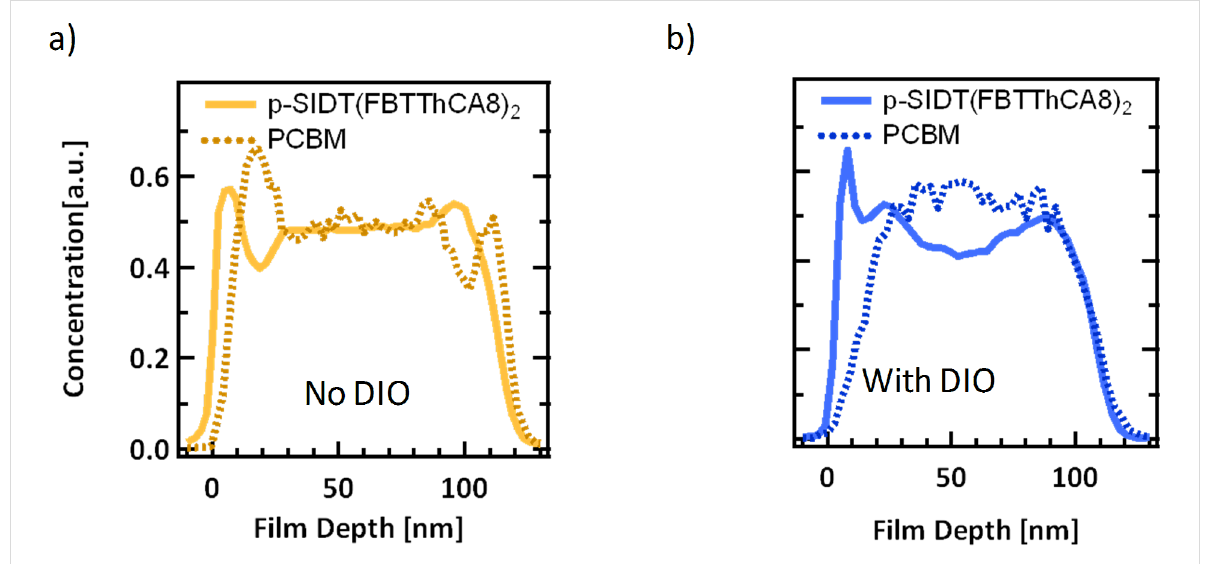
Figure 5: Dynamic secondary ion mass spectrometry (DSIMS) profile showing scaled nitrogen (solid) and deuterium (dashed) signals for films cast a) with no DIO and b) with 1.5%